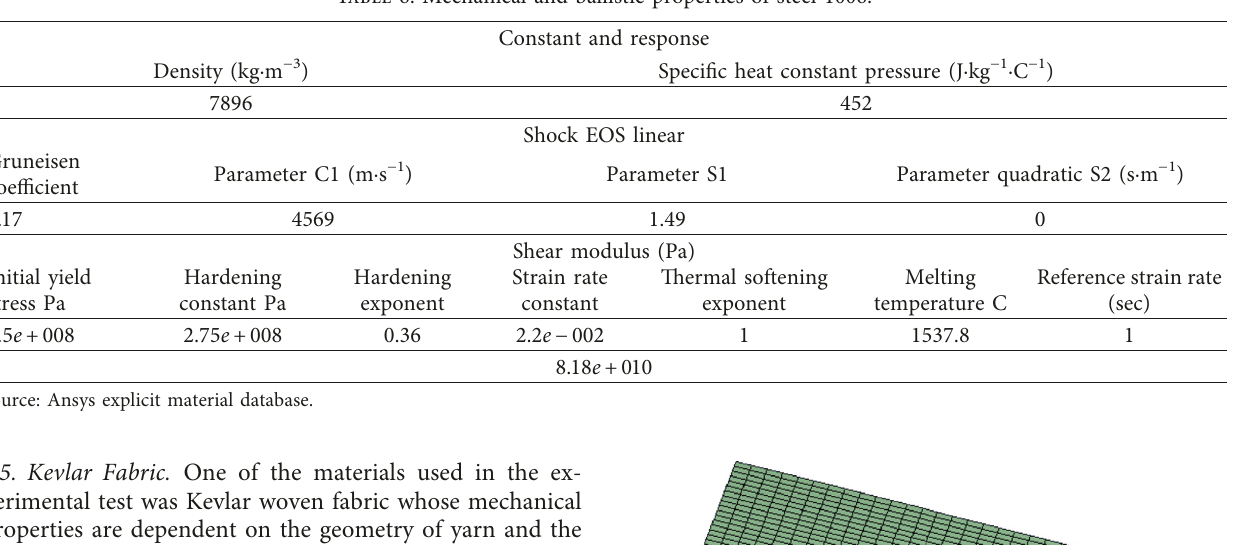
Table 6: Mechanical and ballistic properties of steel 1006.